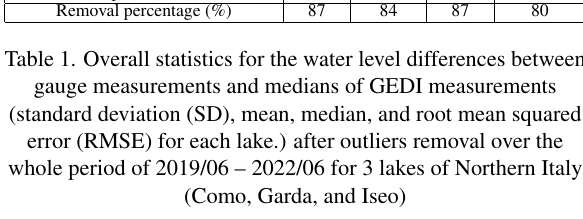
ranging from 0.25 to 0.49 m. The RMSE showed values less than 0.47 m, indicating that the GEDI data correlates well with the gauge station measurements and Figure 4 shows the same pattern and ability of GEDI in following the patterns of the